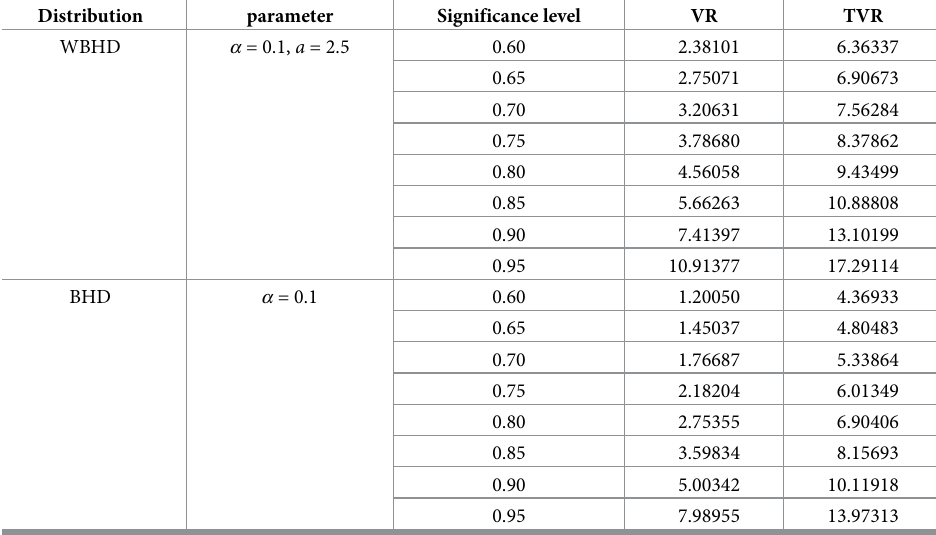
Table 7. Numerical results of VR and TVR for the WBHD and BHD.